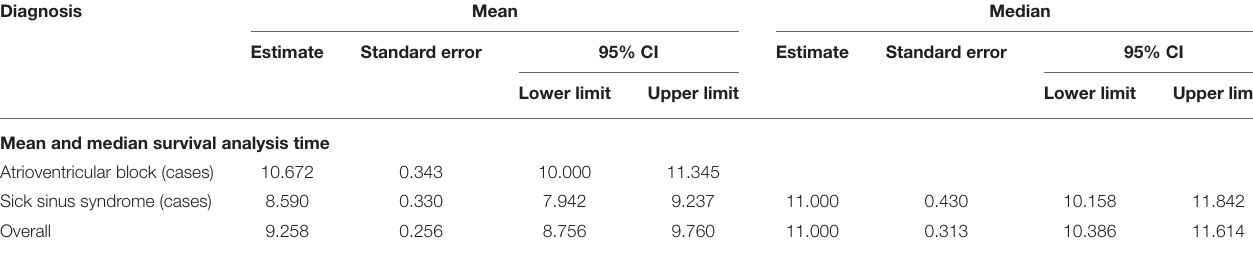
TABLE 6 | Kaplan–Meier analysis of